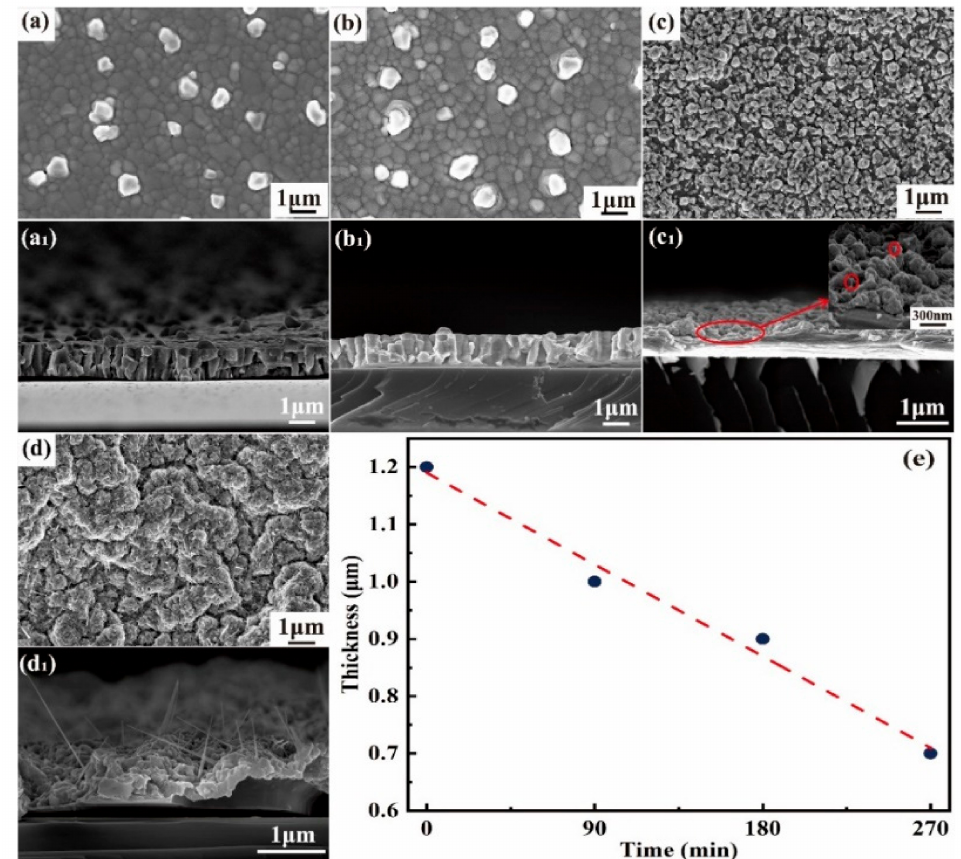
Figure 4. Top-view and cross-sectional SEM images of thin films and nanowires after a growth time of ( a , a 1 ) 0 min (20 ◦ C), ( b , b 1 ) 90 min (250 ◦ C), ( c , c 1 ) 180 min (470 ◦ C), and ( d , d 1 ) 270 min (470 ◦ C); ( e ) Zn film thickness vs. heated